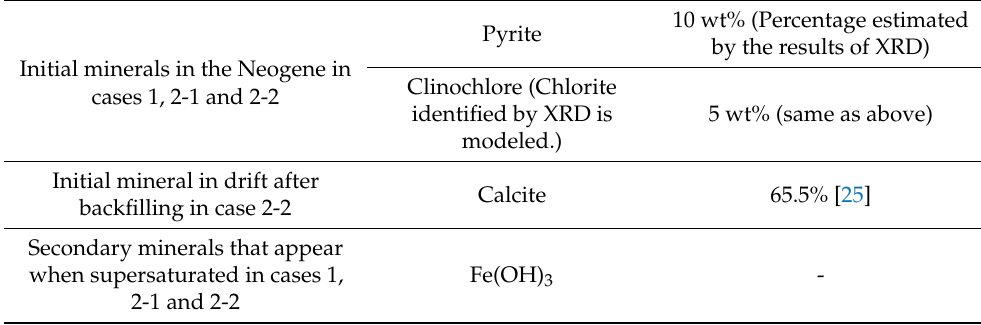
Table 4. Minerals considered in the geochemical